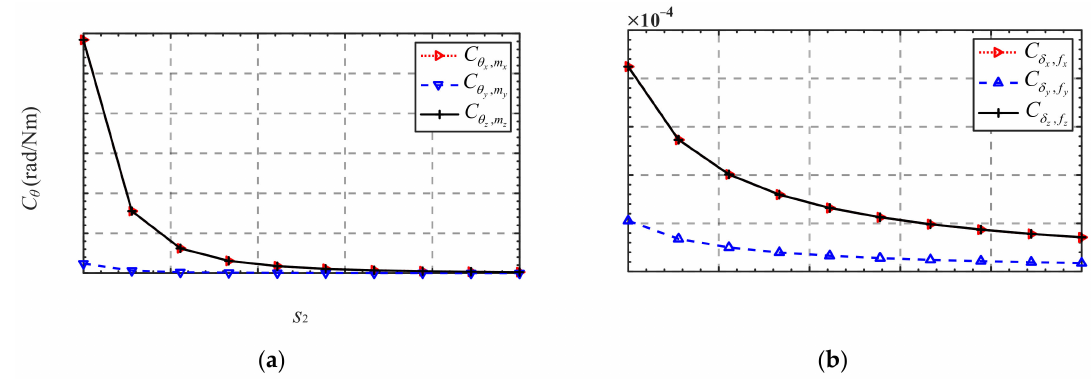
Figure 7. Compliance variation in terms of the scale coefficient s 2 : ( a ) C θ ; ( b ) C δ .